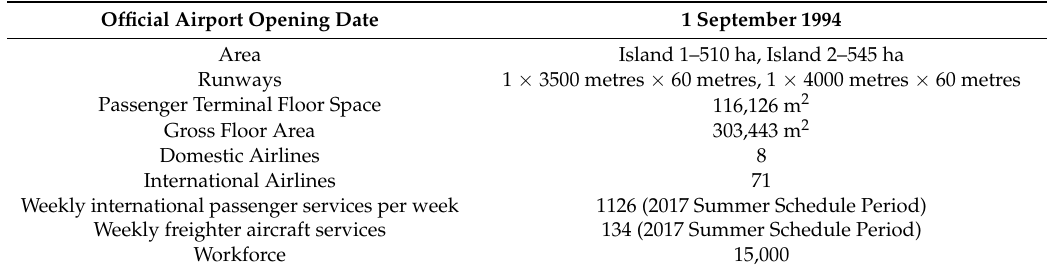
Table 3. Kansai International Airport information, adapted from